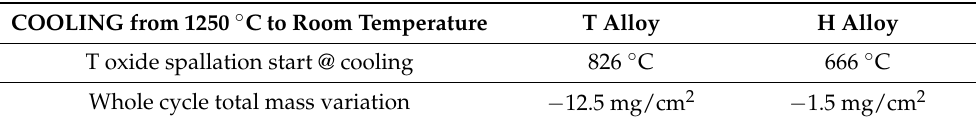
Figure 6. The two {m vs. t}-plotted curves of mass variation at cooling for the two alloys. FIGURE 6 Table 5. Values of various parameters characterizing the spallation behavior during cooling for the two